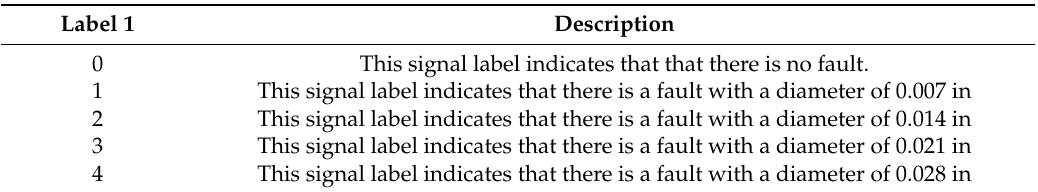
Table 1. The information of labels in dataset D .